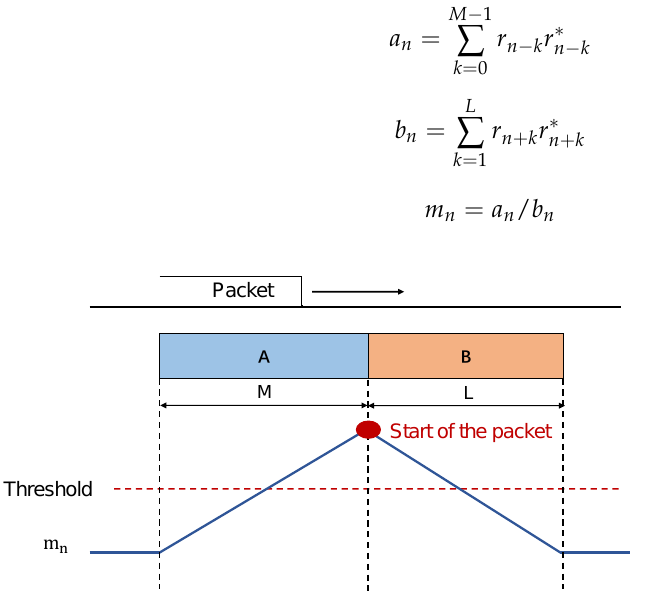
Figure 7. Double sliding window